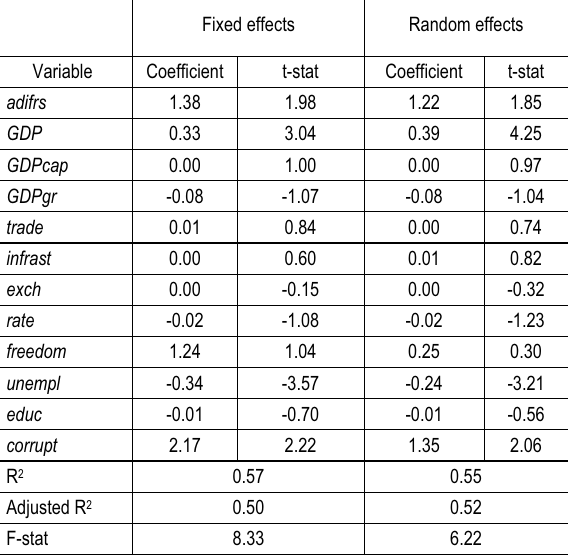
Table 1. Panel data results – full